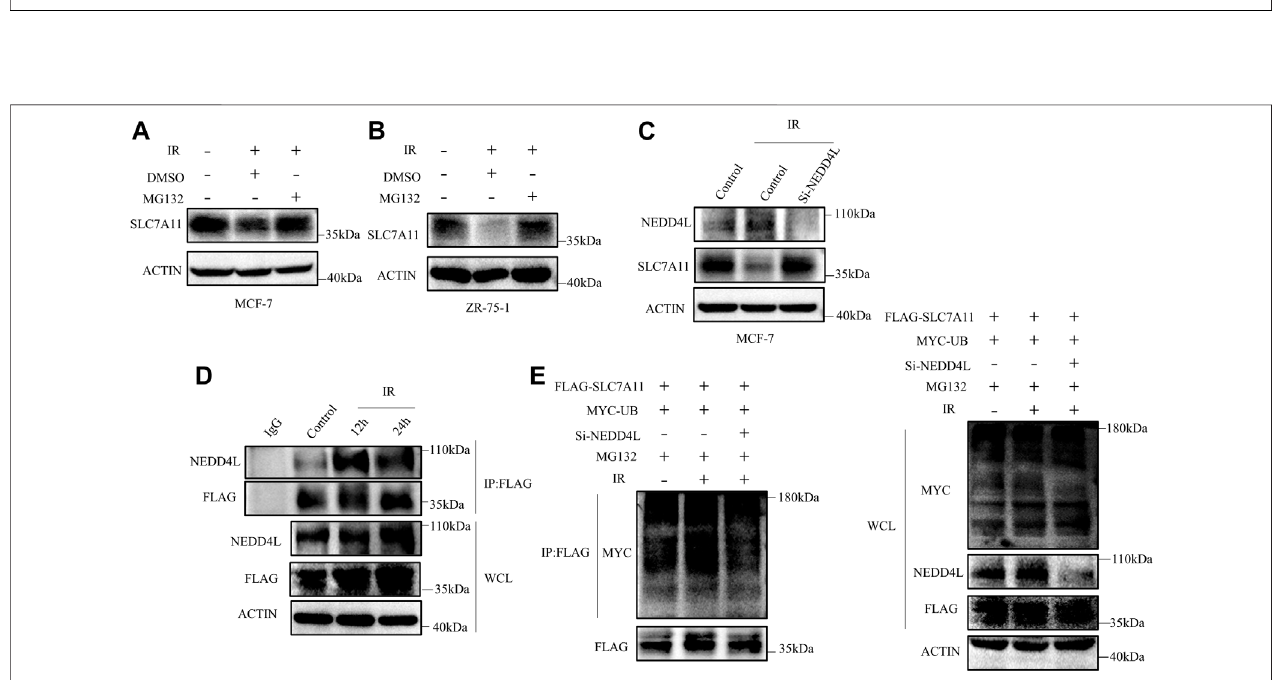
FIGURE 7 | SLC7A11 is degraded by ubiquitination after IR treatment. MCF-7 (A) and ZR-75-1 (B) cells were pretreated with MG132 (10 μ M) or DMSO for 4 h beforeharvest. (C) MCF-7cellsweretransfected withSi-NEDD4L.TheproteinlevelofSLC7A11wasanalyzed byWestern blot. (D) WesternblotanalysisofWCLandIP samplesofIgGoranti-NEDD4LantibodywereconductedtodetecttheinteractionbetweenSLC7A11andNEDD4L.MCF-7cellsweretransfectedwithFLAG-SLC7A11 for 48 h, then treated with IR. MG132 (10 μ M) was added into the culture medium for 4 h before harvest. (E) Western blotting analysis of WCL and ubiquitin IP samples were performed with indicated antibody in MCF-7 cells. The cells were treated with MG132 (10 μ M) for 4 h before harvest.